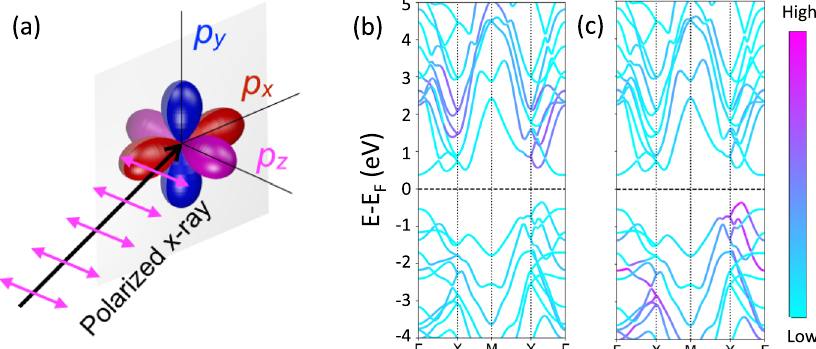
Fig. 1 Experimental geometry and orbital contributions. a The geometry of the sample and incident x-ray in our experiment; the horizontal polarized light (purple arrows) excites the p z orbitals preferentially. b Calculated Ge p z orbital contribution in GeSe band structure. c Calculated Se p z orbital contribution in GeSe band structure. The colorbar indicates the weight of p z contribution in